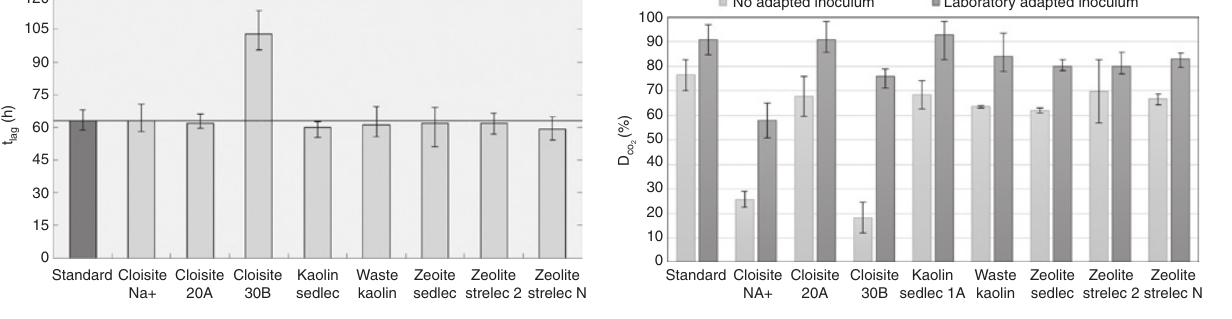
Figure 7: The level of PVA 72-10 biodegradation with no adapted inoculum and laboratory-adapted inoculum in the presence of selected group of clay minerals ( ± standard